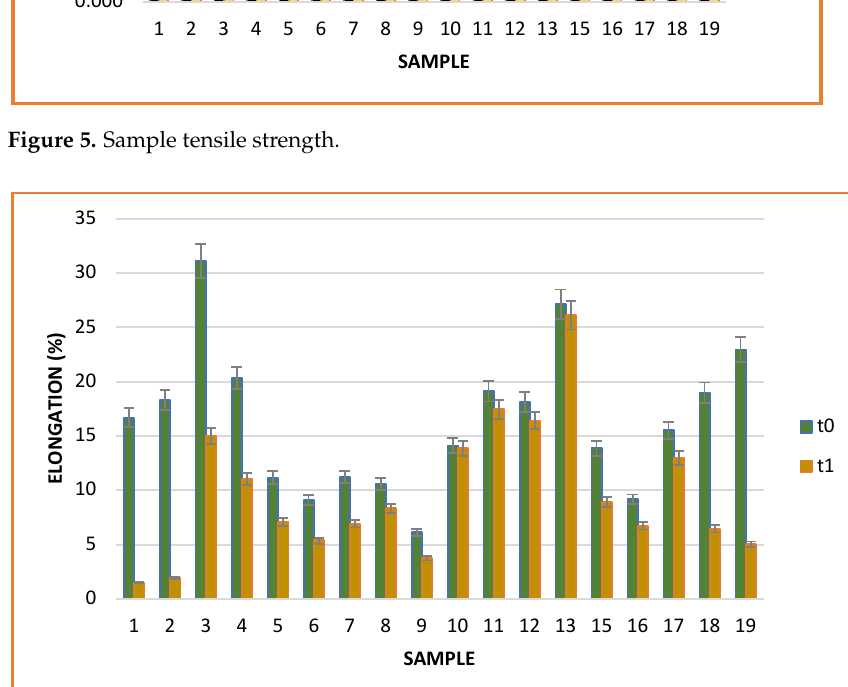
Figure 6. Sample elongation .